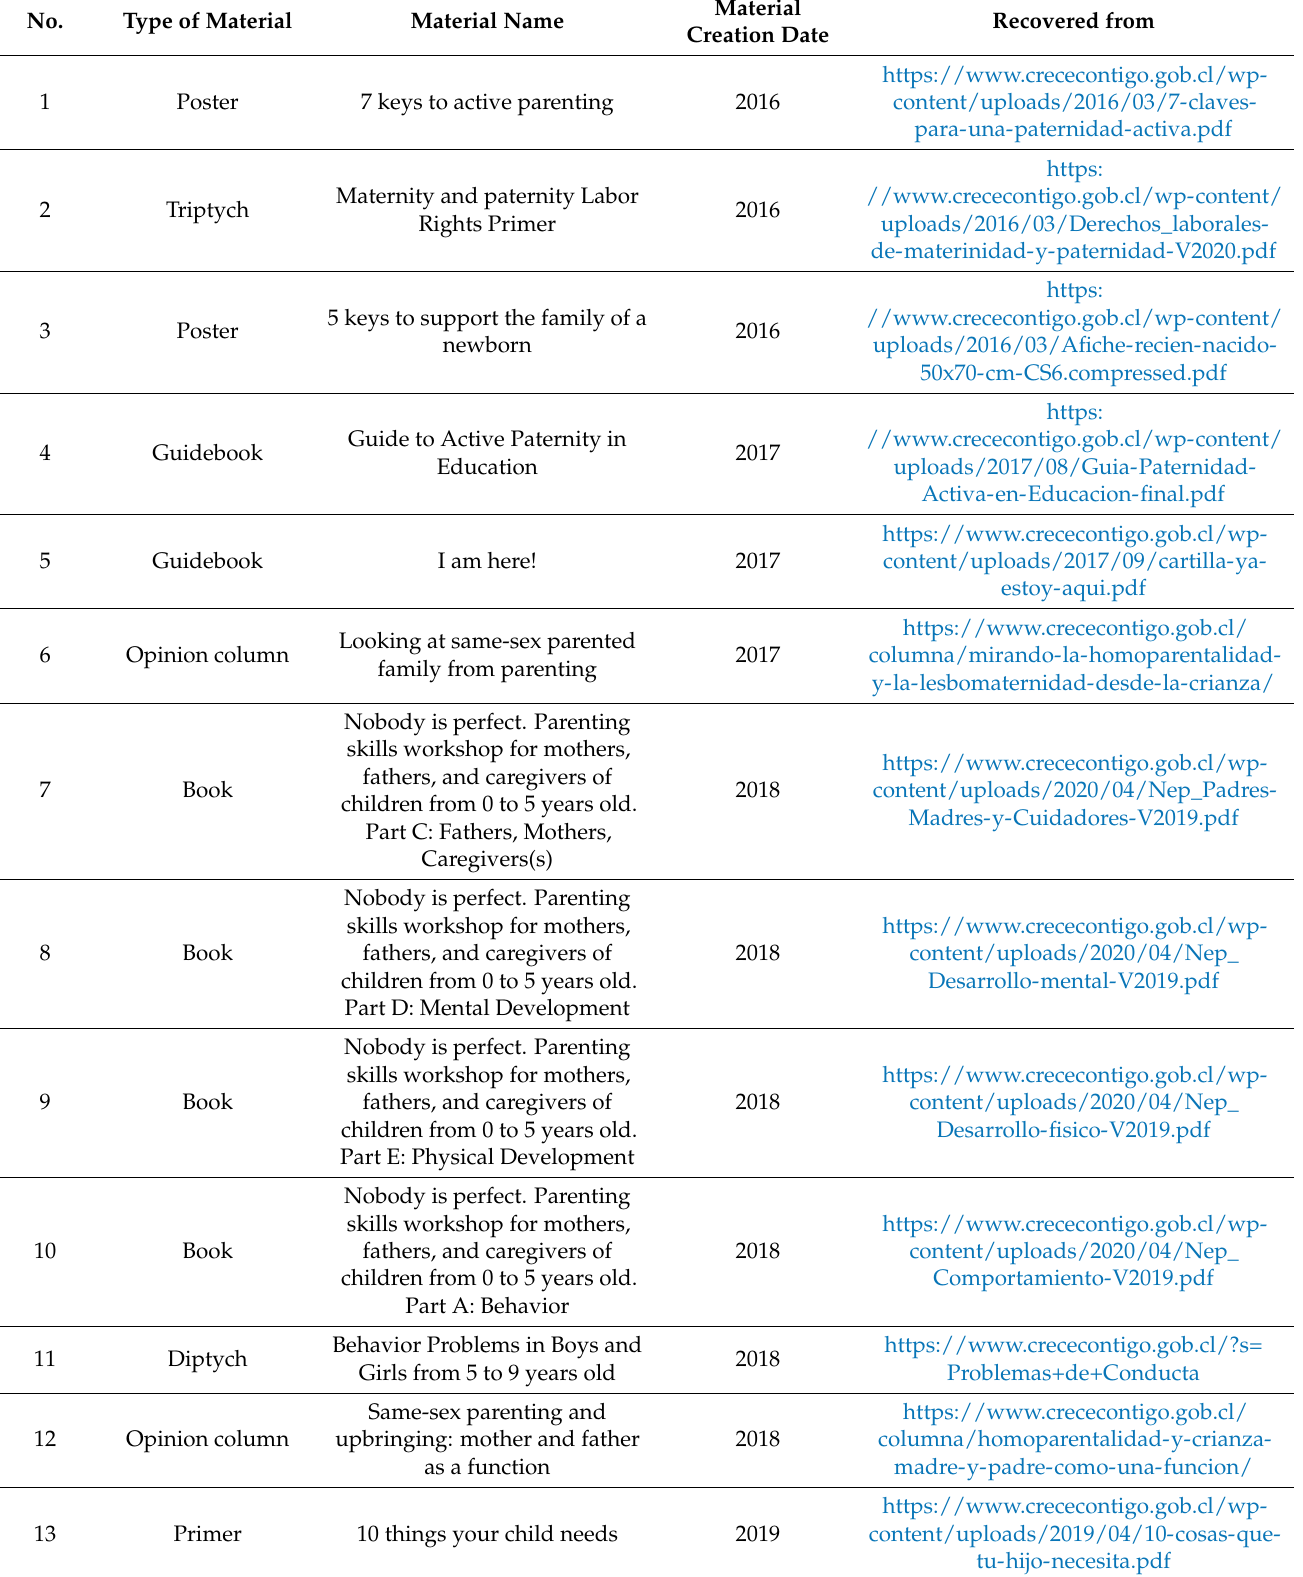
Table 1. Material